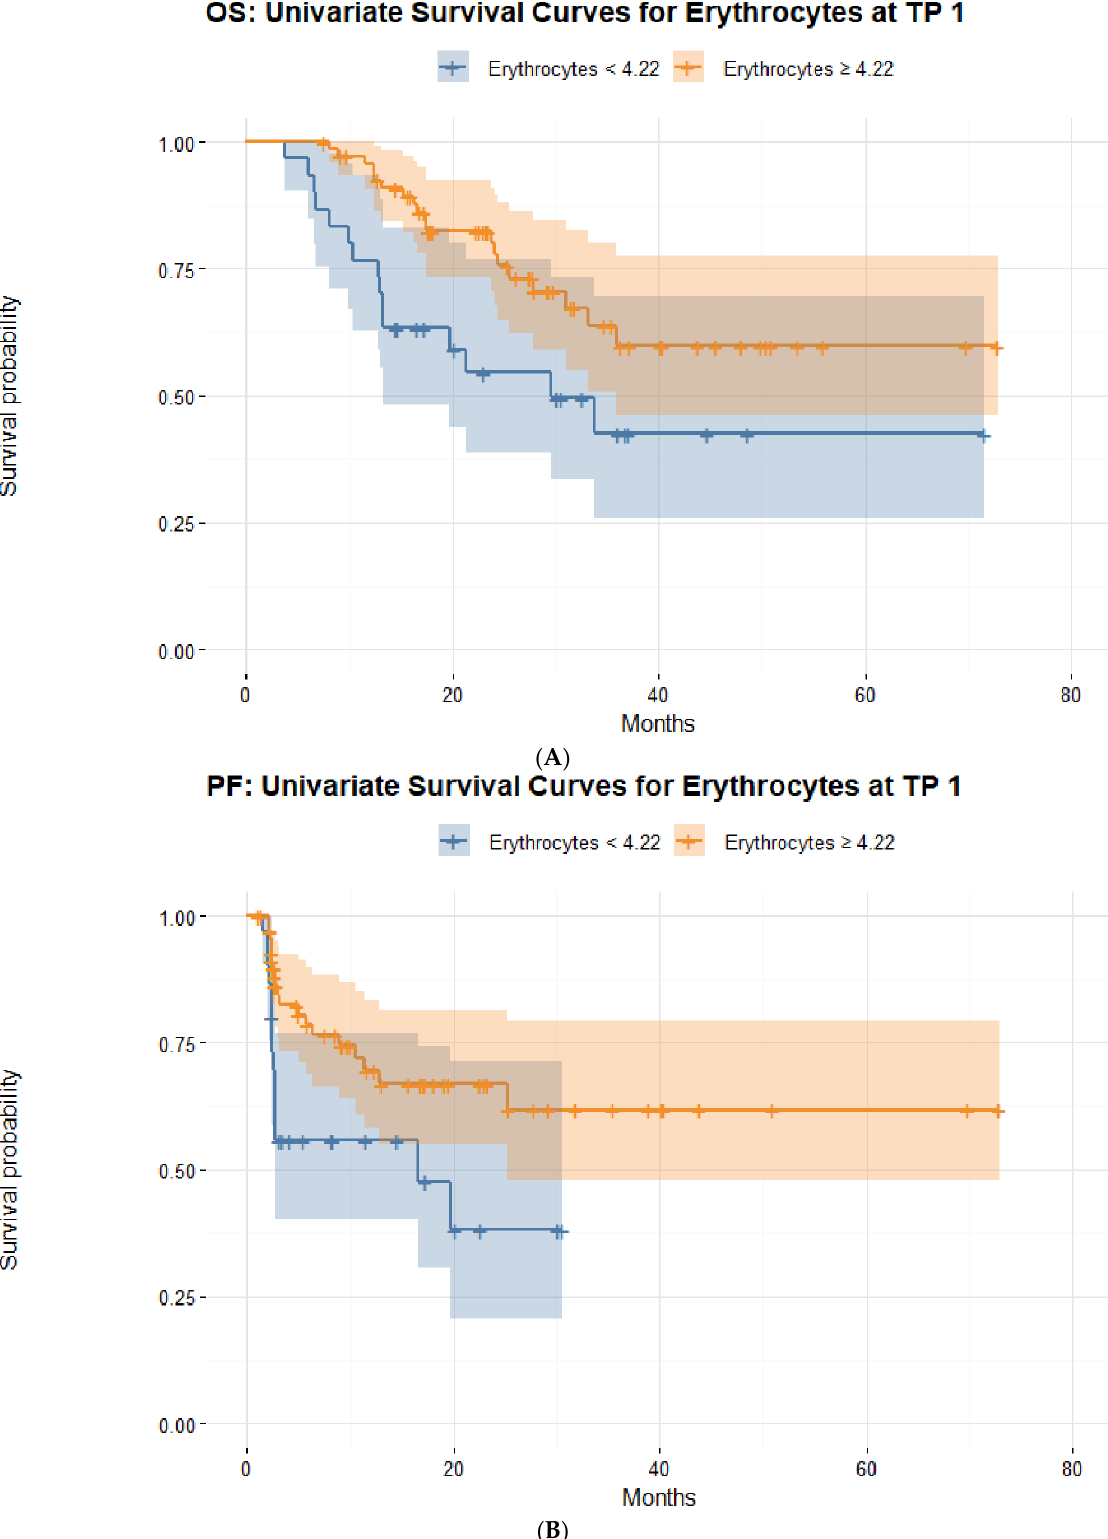
Figure 4. Kaplan–Meier survival curves stratified by the optimal cut-off count of erythrocytes (per pL) three months after initiation of immune checkpoint inhibition in metastatic melanoma patients based on ( A ) overall survival and ( B ) progression-free survival.